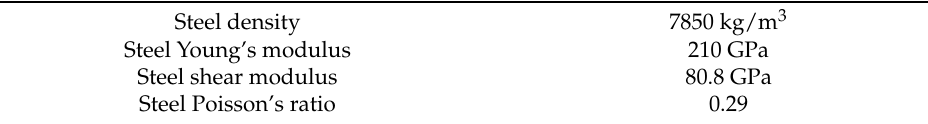
Table 2. Properties of the steel used for the